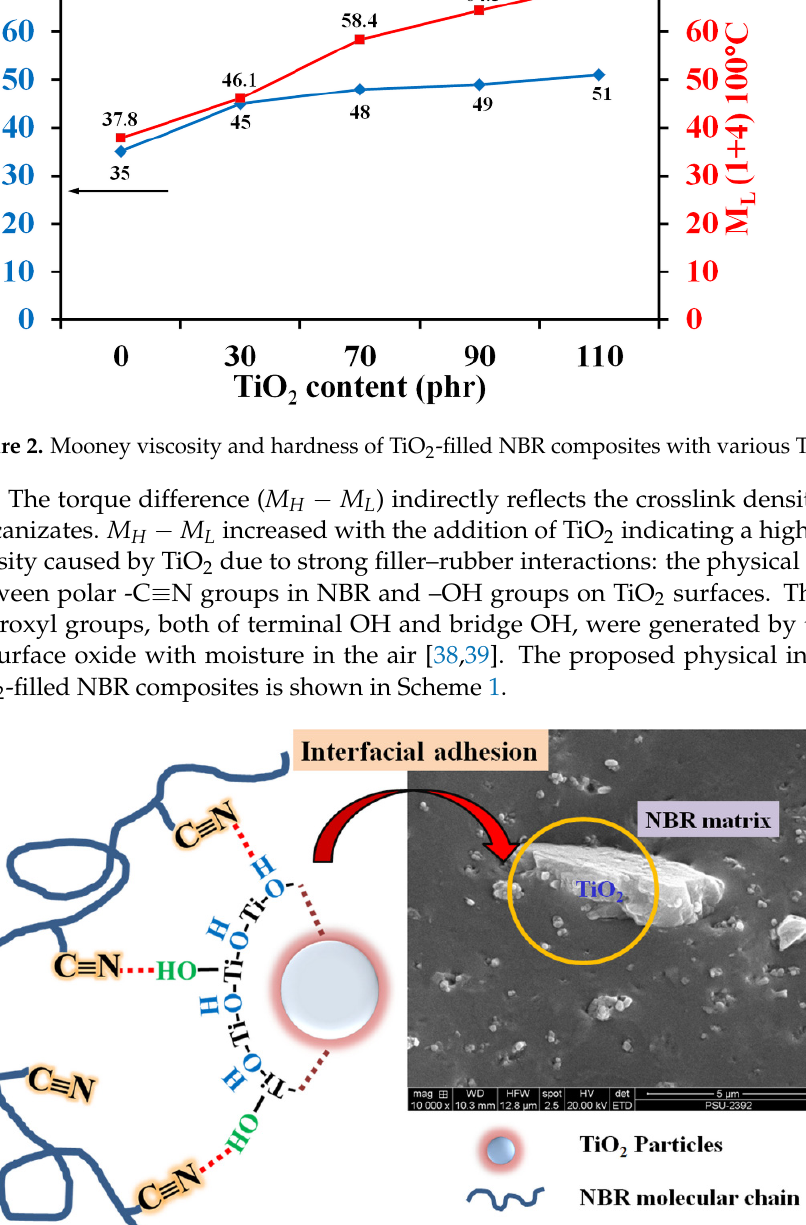
Scheme 1. Schematic diagram illustrating physical bonding and interfacial adhesion in TiO 2 -filled NBR composites.